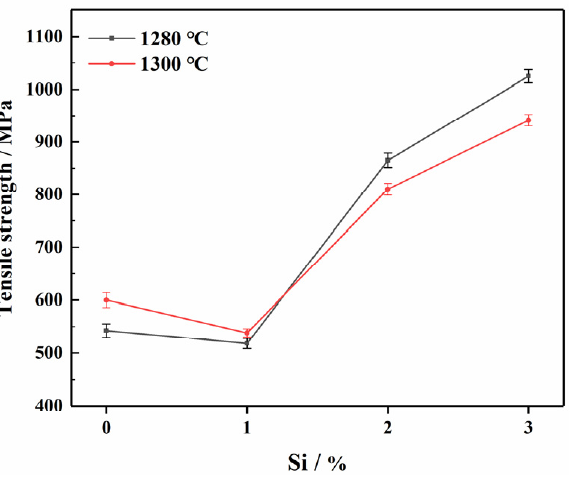
Figure 13. TensilestrengthofODSsteelswith0,1%,2%and3%wtSiat1280 ◦ Cand1300 ◦ Csinteringtemperature. Figure 13. Tensile strength of ODS steels with 0, 1%, 2% and 3%wt Si at 1280 °C and 1300 °C sintering temperature. The tensile fracture morphologies of 1280-S1 and 1280-S3 ODS steels are shown in Figure 14. The fracture modes of the two components were ductile fracture, and the second phase of different sizes were distributed in the center and around the dimples. An EDS